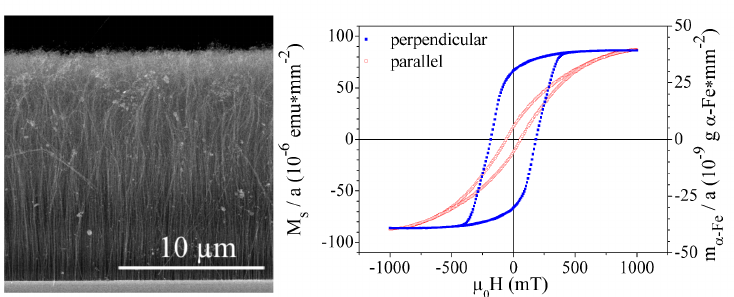
Figure 19. SEM and AGM of a bulk sample [12]. A large hysteresis and anisotropy can be